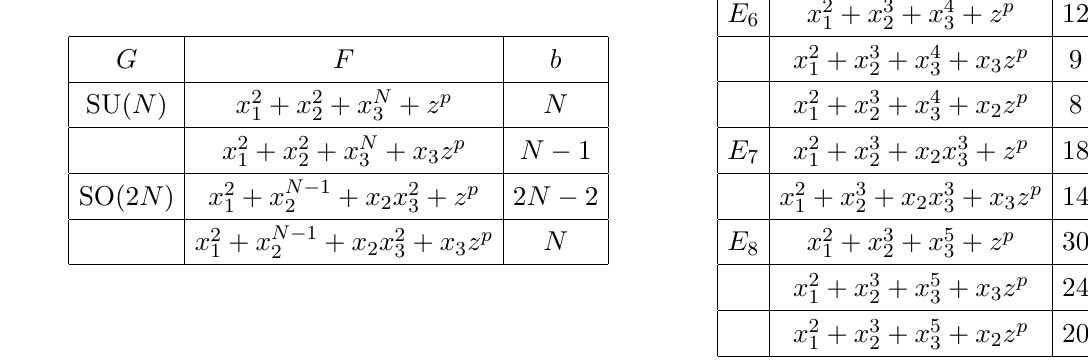
Table 1 . Hypersurface singularities ( F = 0 ) realizing the D b with all the allowed values of b for each G